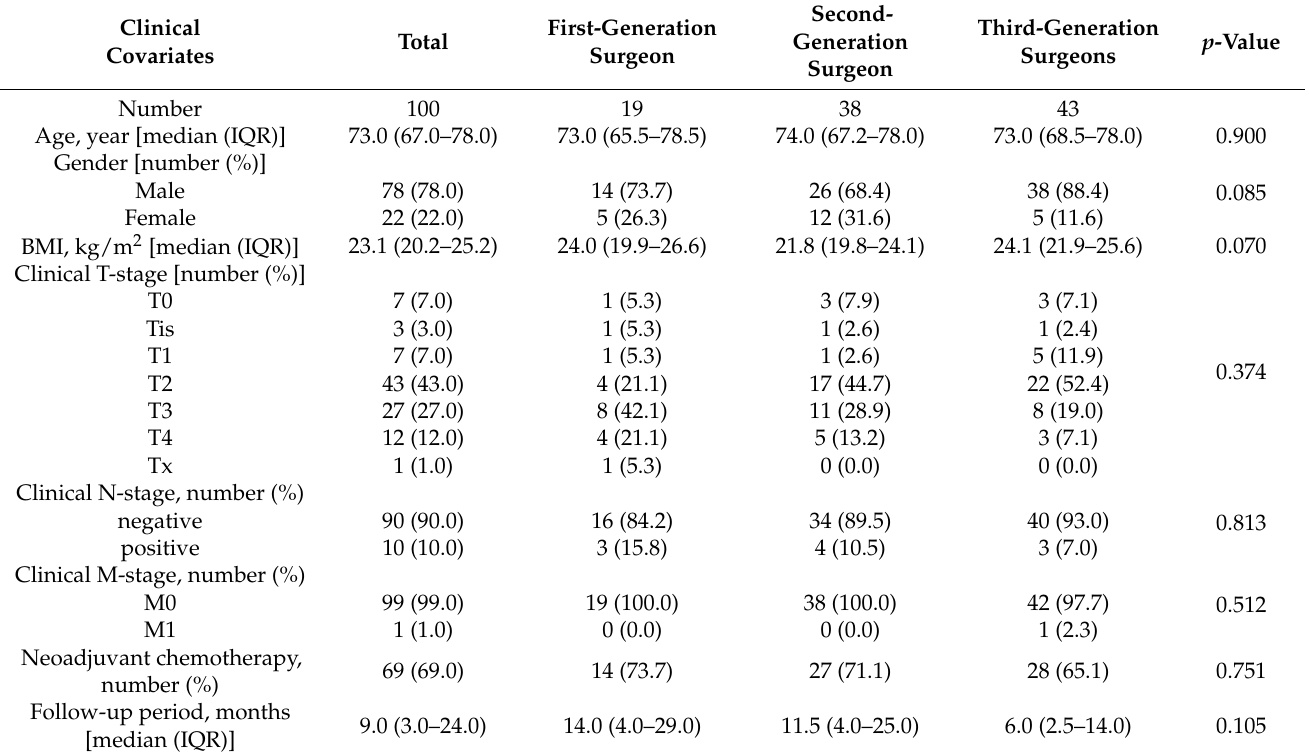
Table 1. Patient characteristics.